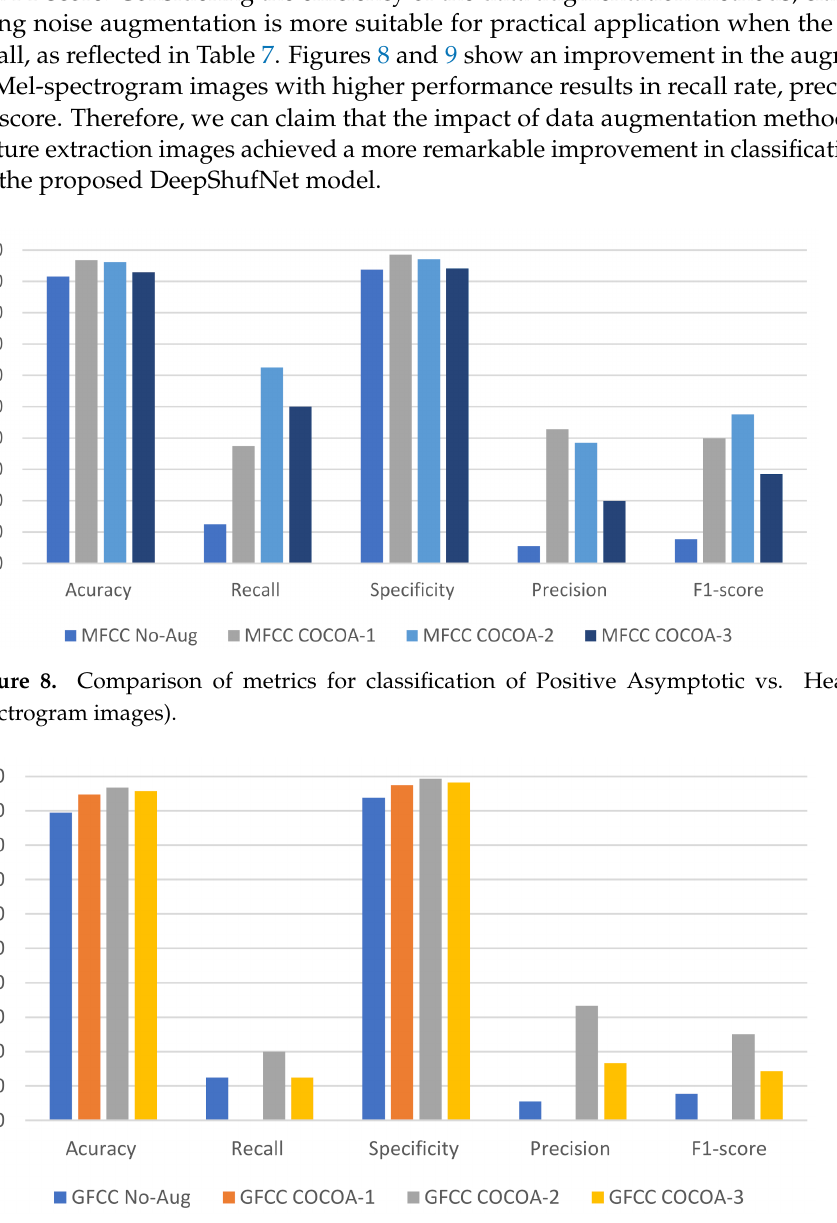
Figure 9. Comparison of metrics for classification of Positive Asymptotic vs. Healthy (GFCC